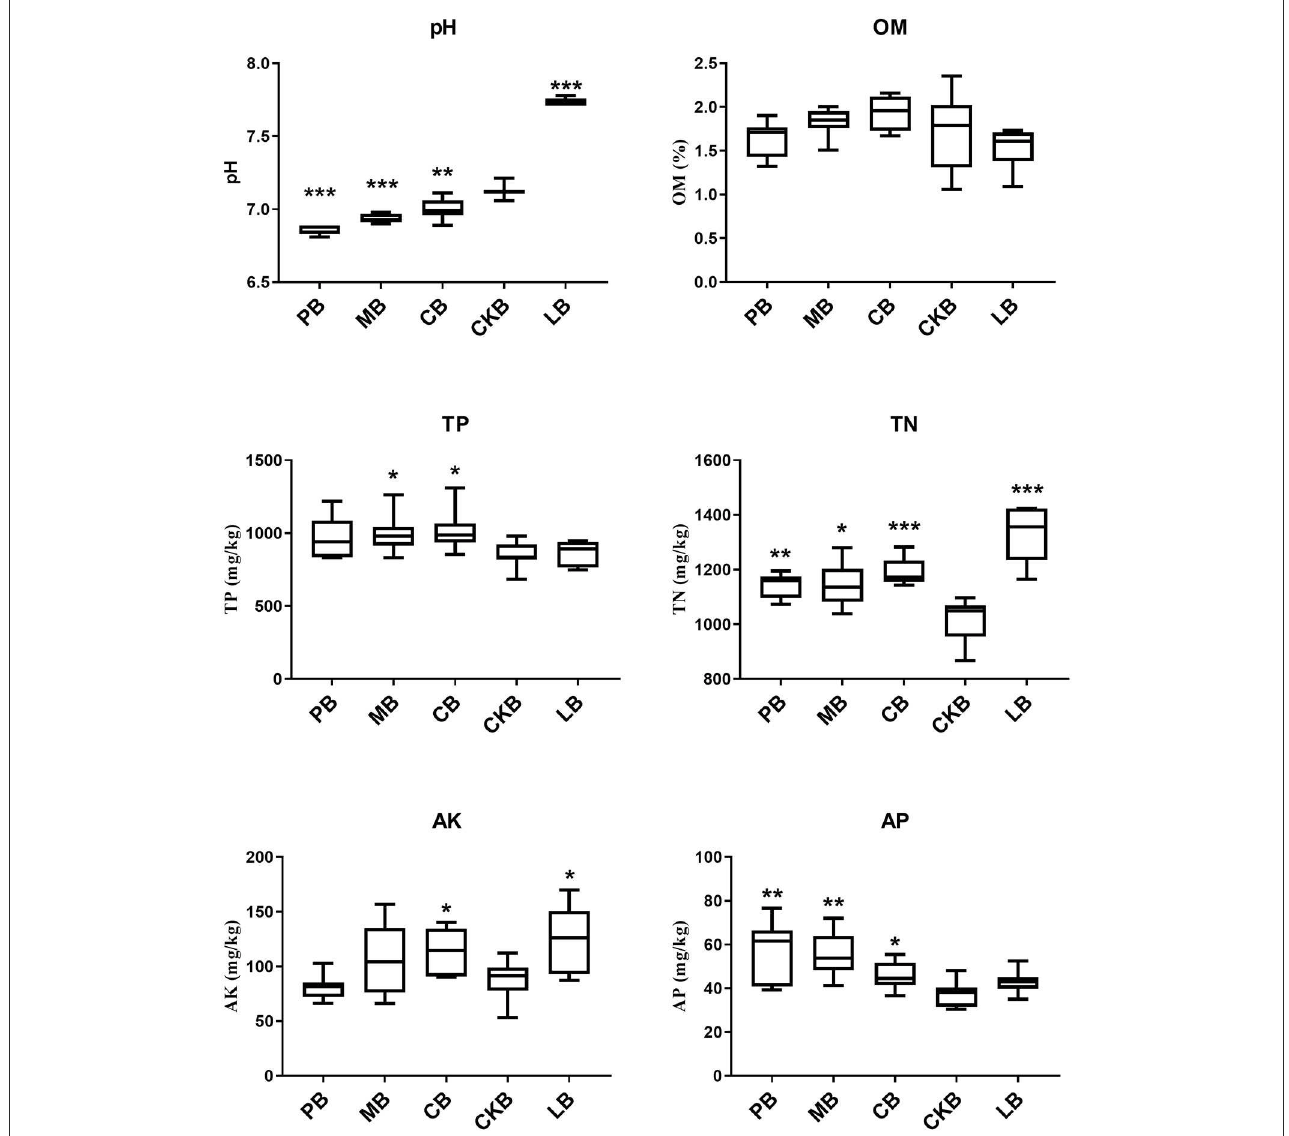
FIGURE2 The physicochemical properties of different treatments. PB, R. palustris PSB06 root-irrigation treatment; MB, farm manure treatment; CB, formal fertilizer treatment; CKB, control treatment; LB, pre-planting soil sample group, n = 7. “ * ”, “ ** ”, “ *** ” indicate significant difference between treatments and control group, significance level at P < 0.05, P < 0.01, P <